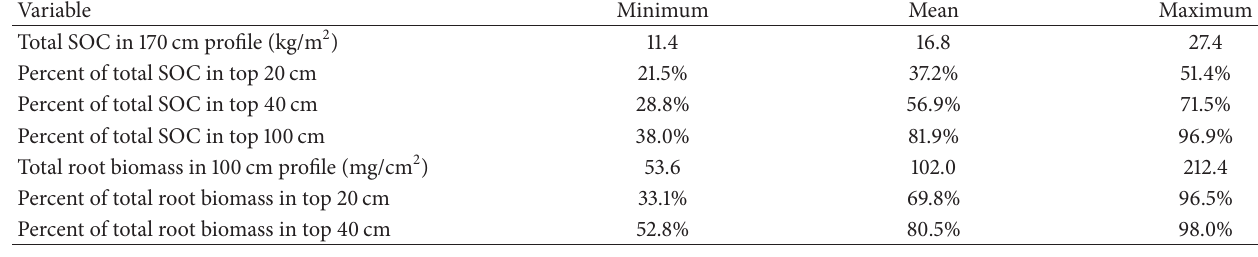
Table 2: Descriptive statistics for soil organic carbon (SOC) and root biomass from 31 vegetation plots across five study tracts in the Grand River Grasslands of Ringgold County, IA, and Harrison County, MO, USA.